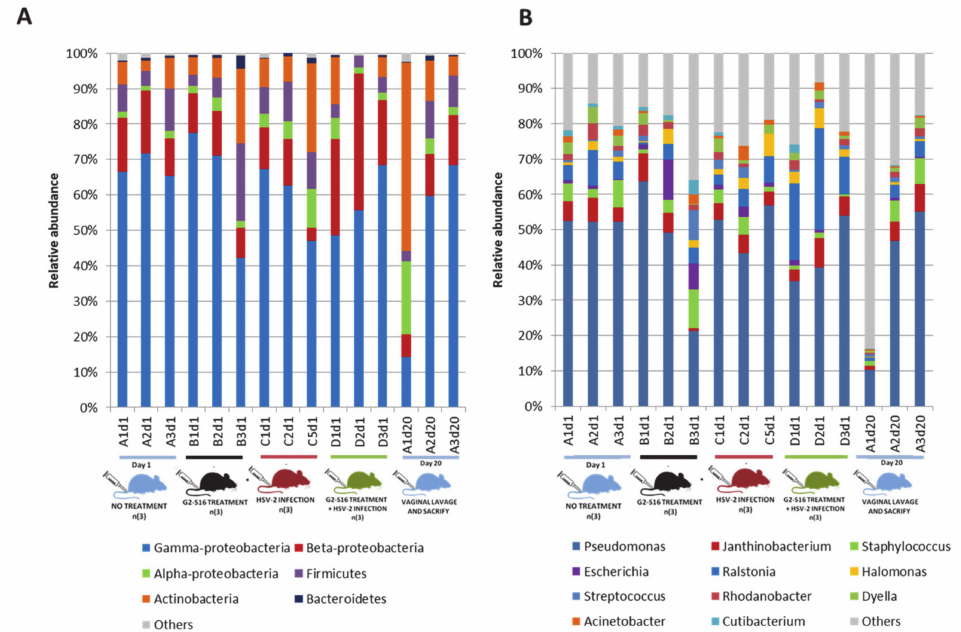
Figure 3. Composition of the vaginal microbiome in healthy mice (group NT). Relative abundances at ( A ) phylum level and ( B ) genus level. The relative taxonomic abundances were calculated from metagenomic data. Taxonomy was assigned when reads showed ≥ 70% identity against subjects in the nucleotide (nt) database (NCBI). Coding color and nomenclature of samples analyzed by metagenomics are those used in Figure 2: capital letter “A–D” refers to the type of samples (A = healthy untreated; B = treated with dendrimer; C = infected with HSV-2; D = treated with dendrimer and post-infected with HSV-2), number “n” refers to replicate samples, and “d-number” refers to sacrificed